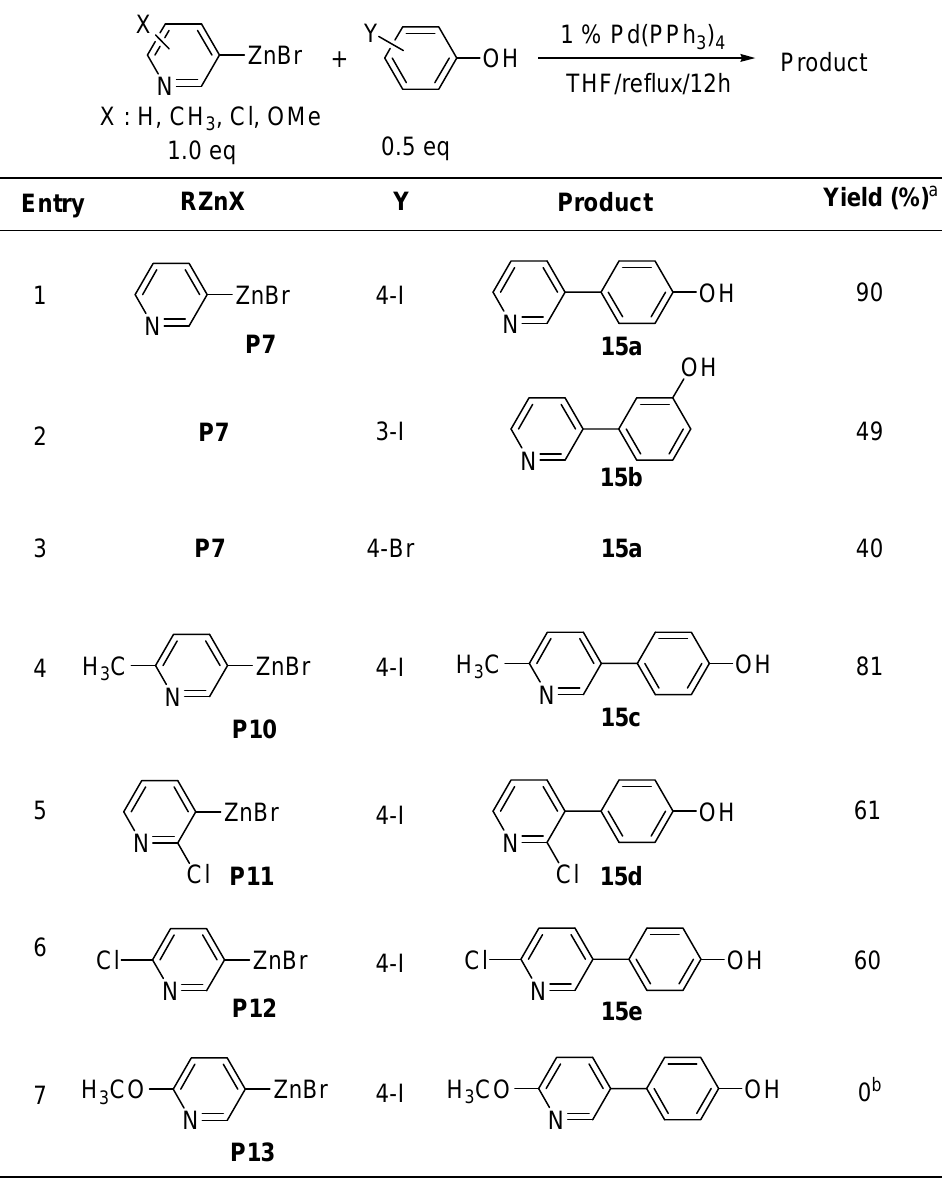
Table 15. Preparation of